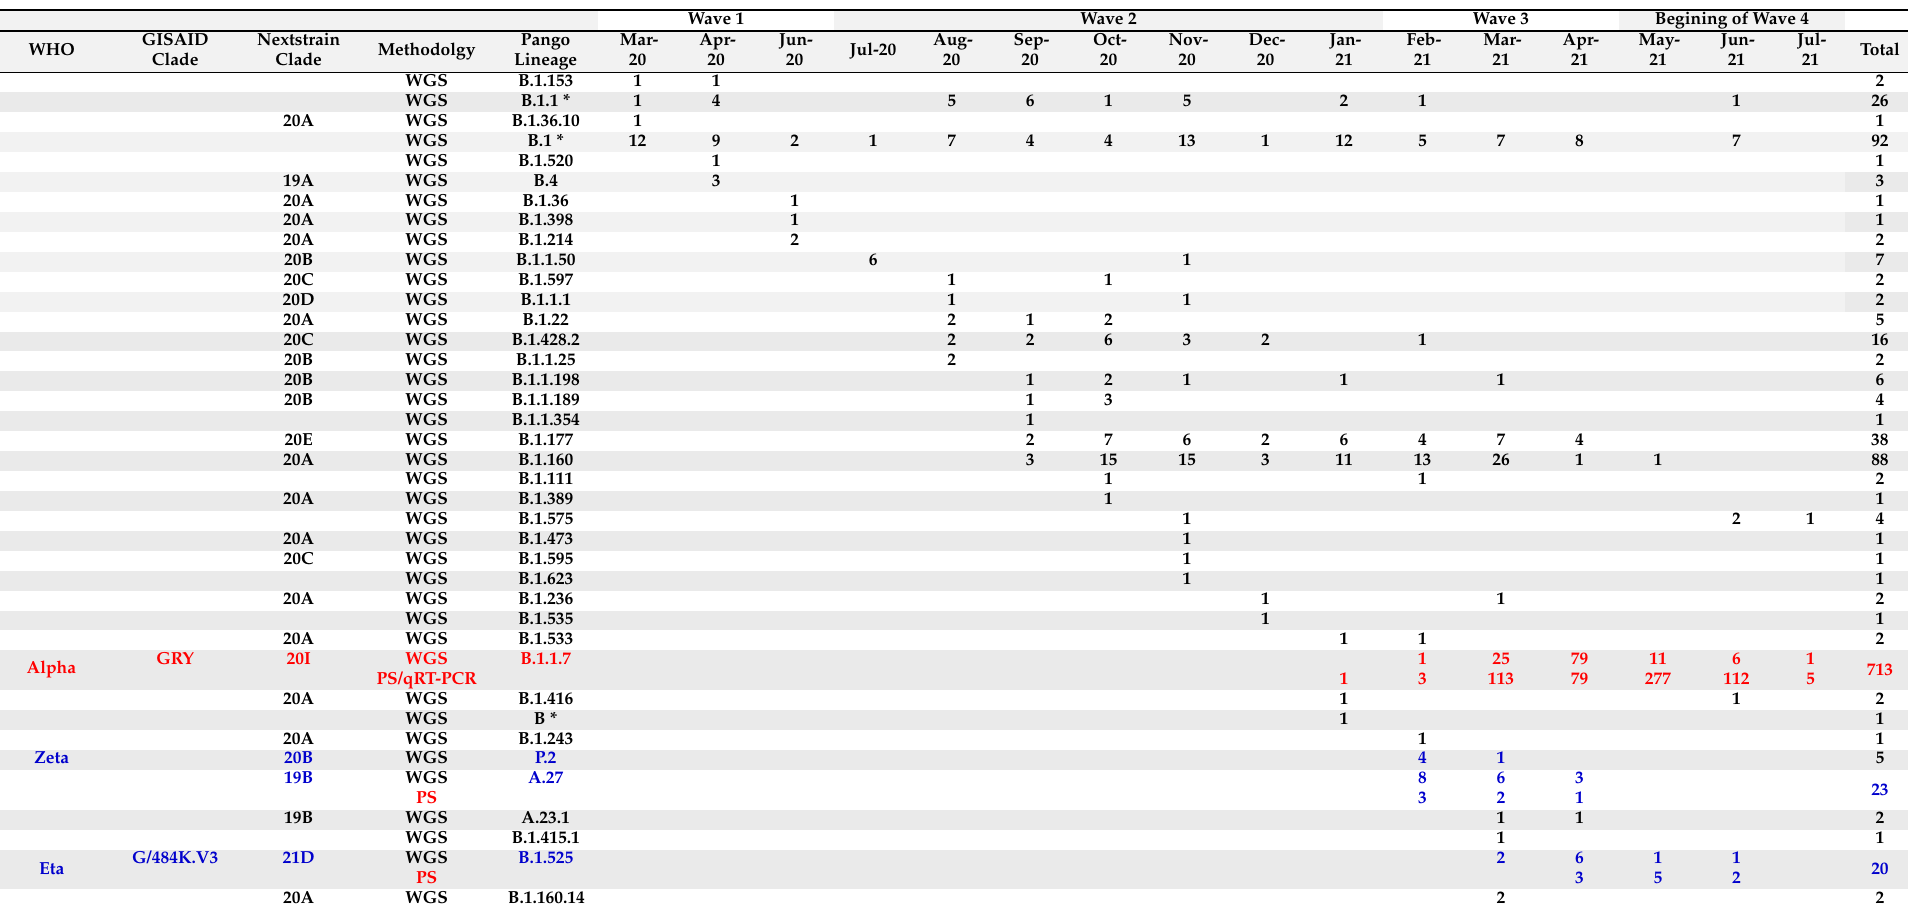
Table 1. Severe acute respiratory syndrome coronavirus 2 (SARS-CoV-2) lineage distribution in Tunisia from March 2020 to July 2021 according to month of sample collection. Variants of concern (VOCs) and variants of interest (VOIs) are shown in red and in blue, respectively. Wave 1 Wave 2 Wave 3 Begining of Wave 4